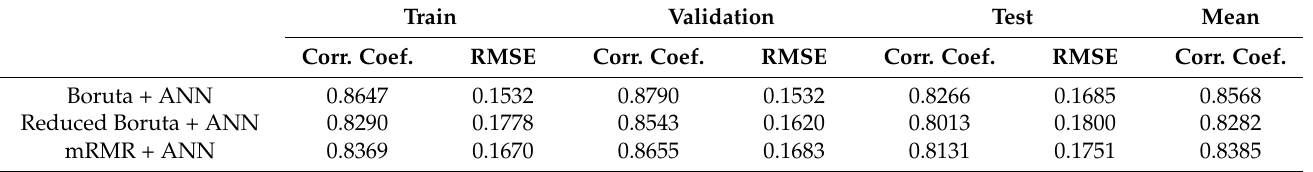
Table 6. Acronyms of the variables selected for the model of the noise interference with the syn- chronous activities using the Boruta (first column) and mRMR (third column) feature-selection methods listed by descending order of importance (using the Boruta relative importance and the mRMR scores, respectively). The second column shows a list with the same number of variables selected by the MRMR method, but it is composed of the first Boruta-selected variables. The meanings of the acronyms of the variables selected for the models are shown in Table A1. Boruta Table 7. ANN results for the best-performing models of noise interference with synchronous activities using the variables selected by Boruta, mRMR, and the set of reduced Boruta. The table shows the correlation coefficient and the root mean square error (RMSE) for the train, validation, and test sets. ANN Model of the Noise Interference While Performing Synchronous Academic Activities Train Validation